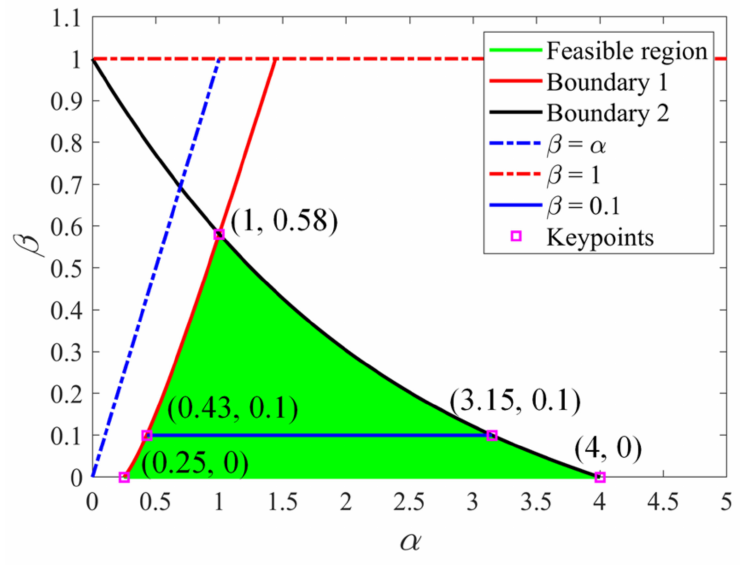
Figure 3. Feasible region of geometric parameters.